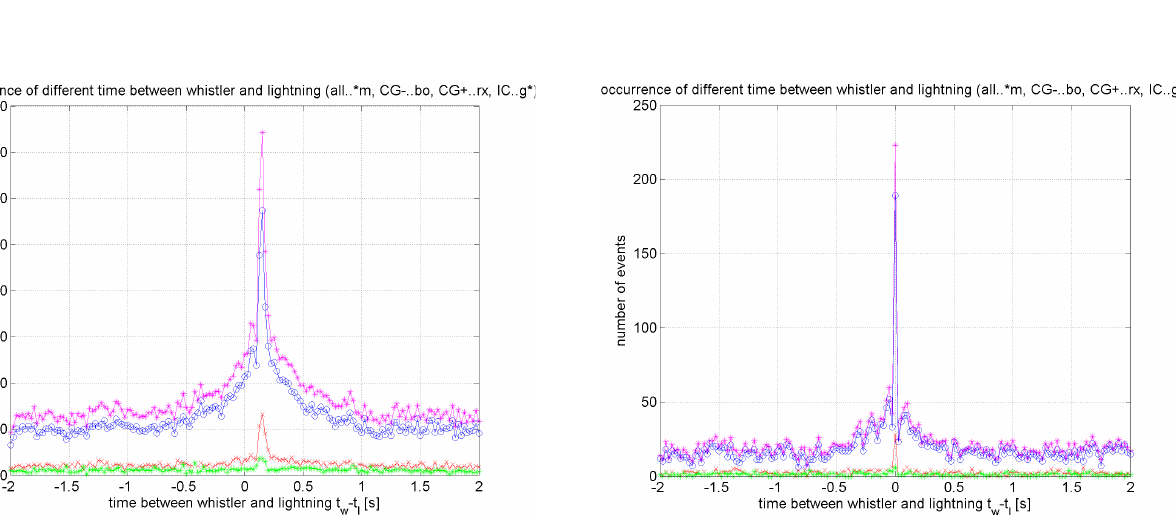
Fig. 3. Occurrence histogram of time differences t wi − t lj between whistler observation ( t wi ) and lightning discharge detection ( t lj ) . The histogram corresponds to the analysed period from 00:15 UT to 00:35 UT on 5 June 2000 and to the VLF record by MAGION- 5 during the nighttime conditions. Asterisks (magenta) correspond to all discharges, circles (blue) to − CG discharges, crosses (red) to +CG discharges and asterisks (green) to IC discharges.